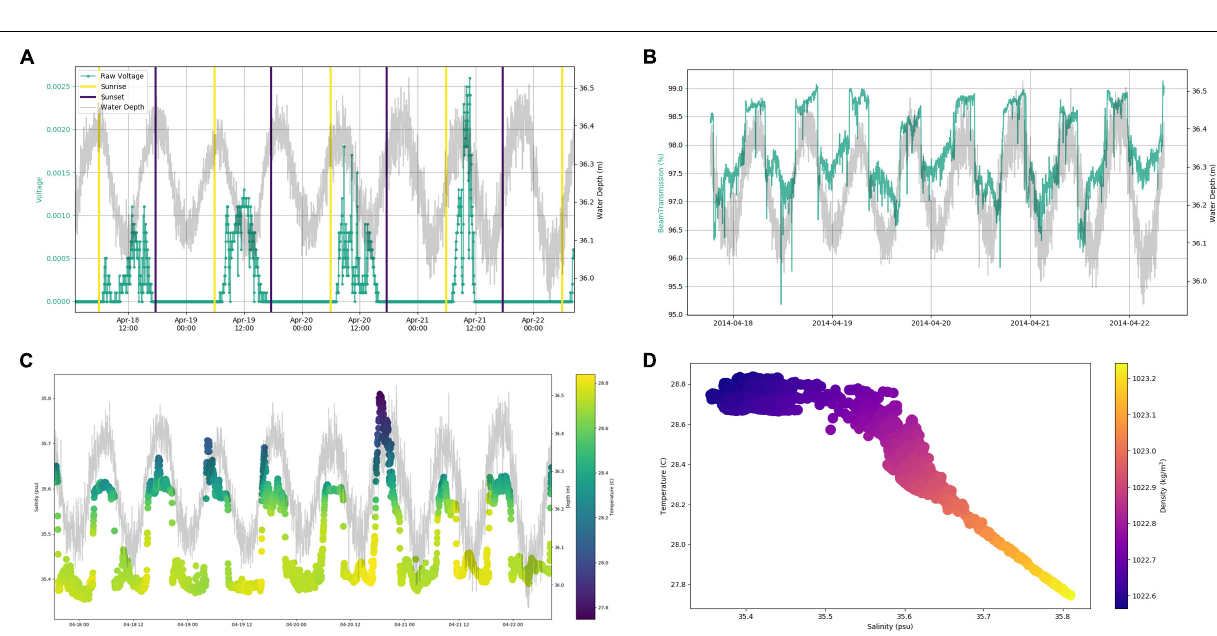
FIGURE 6 | (A) Raw voltage from BioSpherical Instruments QSP-2200PD PAR sensor. Voltage indicated by aqua line. Yellow lines indicate sunrise. Dark blue lines indicate sunset. Sunrise and sunset are from the NOAA Solar Calculator (http://www.esrl.noaa.gov/gmd/grad/solcalc/). Gray line indicates water depth in meters derived from Sea-Bird Electronics 19plus CTD. (B) Light transmittance (%) over time with water depth in Tiputa Channel at mooring C. Light transmittance data from Wet Labs C-Star transmissometer. Transmittance (aqua) values. Gray line indicates water depth in meters derived from Sea-Bird Electronics 19plus CTD. (C) Temperature and salinity plotted with water depth over time. Color indicates temperature in ◦ C with yellow being warmer and blue colder. Salinity is in psu. Water depth is (in m) is indicated by gray line. Temperature, salinity, and pressure data from Sea-Bird Electronics 19 plus CTD. (D) Temperature, salinity, and density. Temperature is in ◦ C. Salinity is in psu. Colors indicate density in kg m - 3 with yellow being denser and blue being less dense. Data for A–C were retrieved from mooring C (depth 37 m) from 18 April 2014 through 22 April